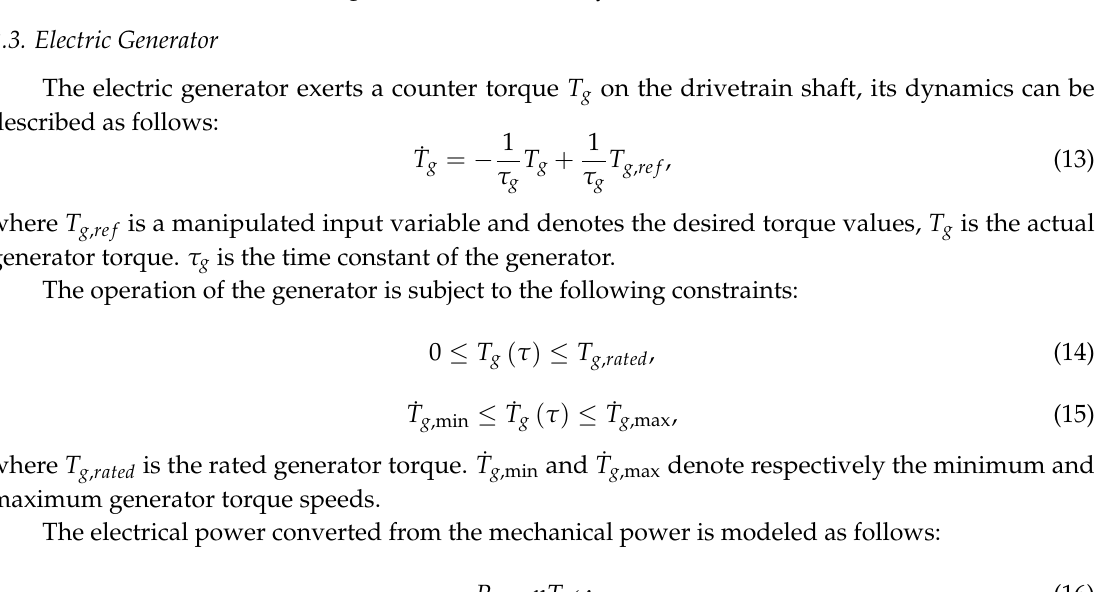
Figure 3. Drivetrain shaft system of